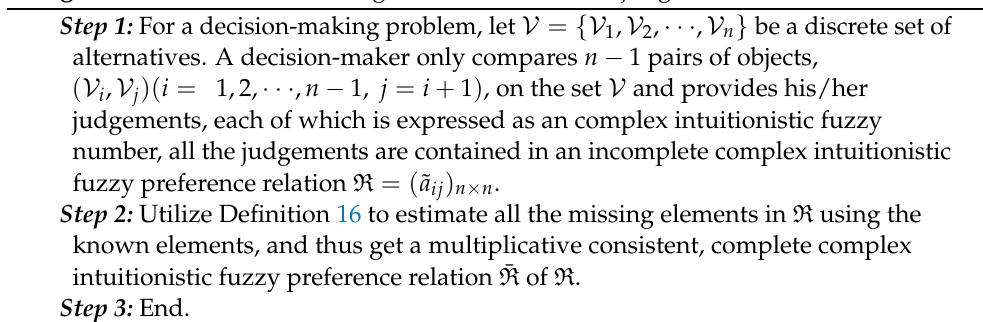
Algorithm 1: The estimation algorithm with the least